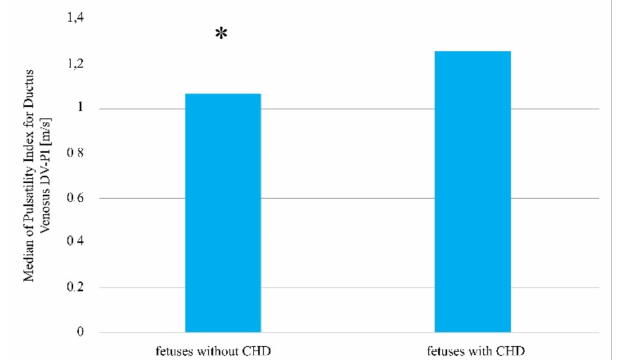
Figure 4. The venous flow rate in fetuses with and without a detected heart defect amongst pa- tients after the induction of ovulation, who later became pregnant as a result of sexual intercourse. * Statistically significant difference (Mann–Whitney U test; p < 0.05).